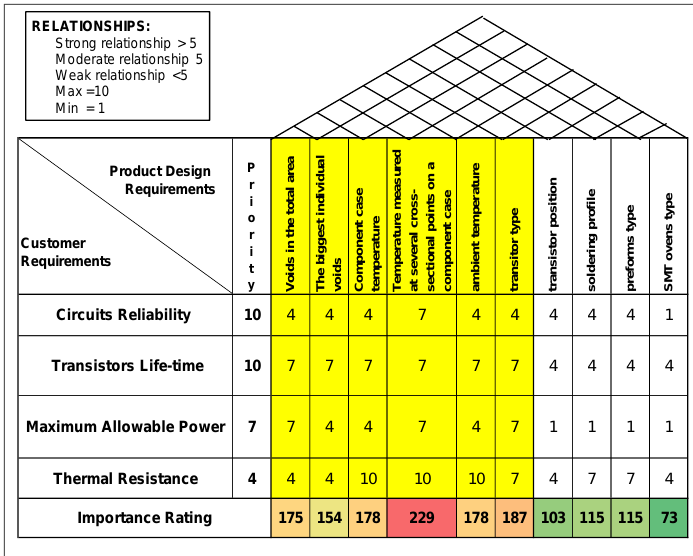
Figure 3. QFD analysis using the House of Quality data matrix to determine the most important factors influencing the customer’s requirements.